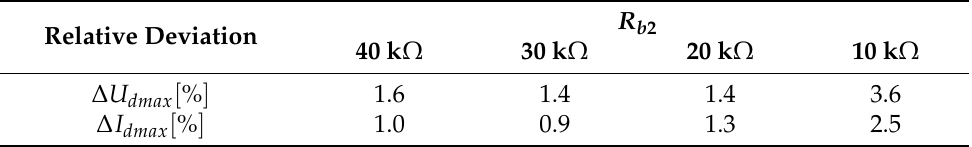
Table 4. Maximum relative deviation of the discharge voltage ( ∆ U dmax ) and current ( ∆ I dmax ) from average values for different ballast resistance R b 2